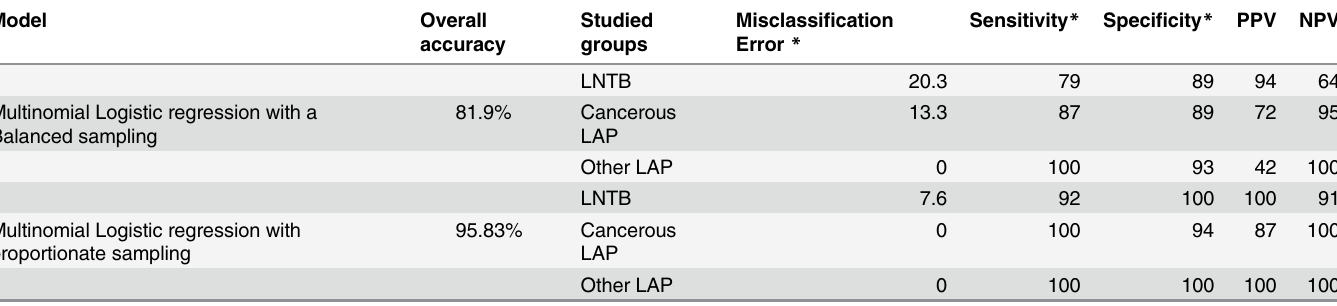
Table 5. Overall performance characteristics of the multinomial models build using IL-10, IL-8 and TNF- β levels as classifying variables.